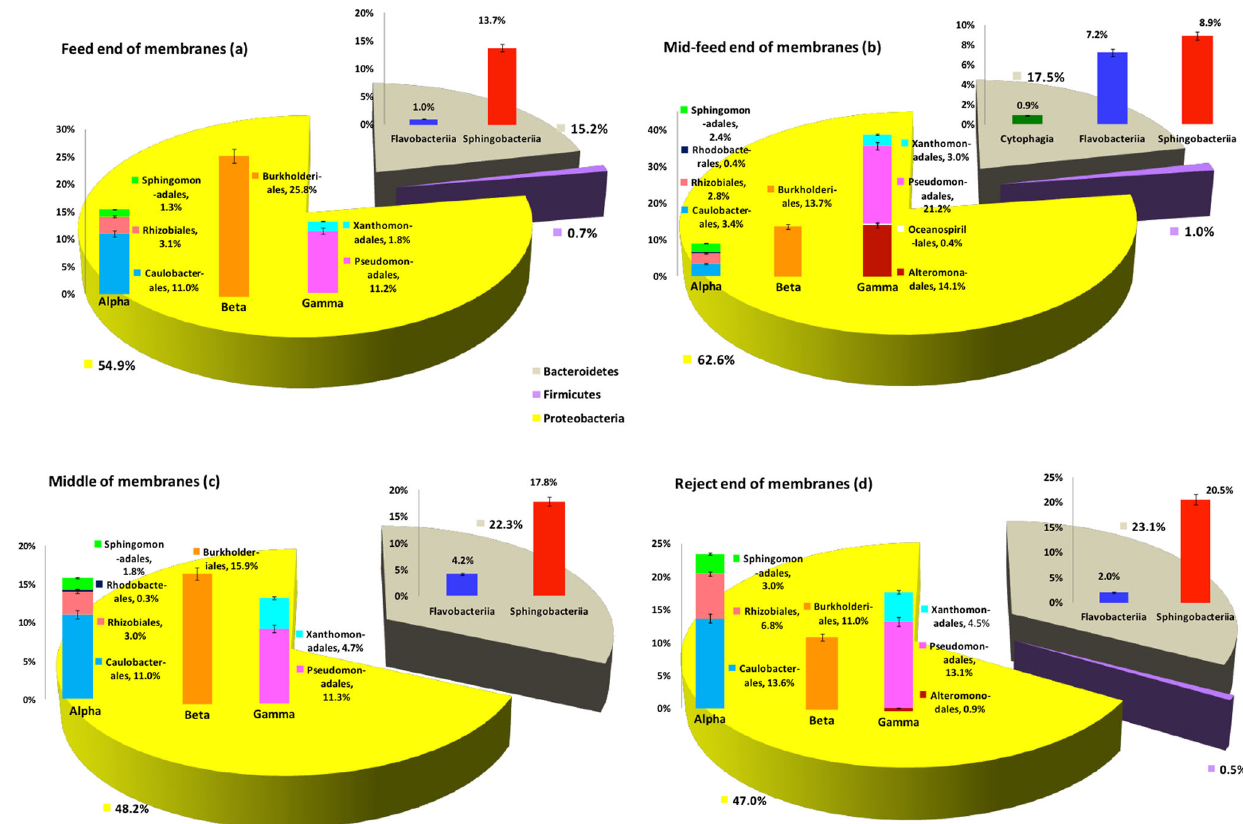
Fig. 7 Abundance of major bacterial taxa (%) per unit biomass volume of RO-membrane-bio fi lm, present in the feed ( a ), mid-feed ( b ), middle ( c ) and reject ( d ) end of the membranes. Error bars represent percent SE Table 2. Diversity indices in different matrices among treatment groups of membranes